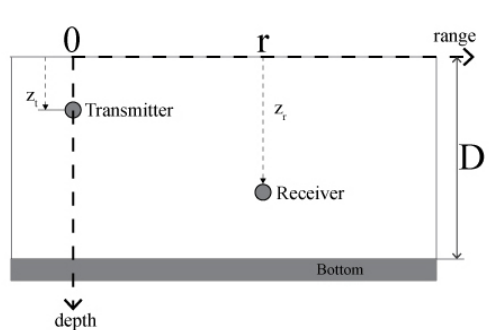
Figure 1. The considered underwater isovelocity setup. Water depth is D , transmitter depth is z t , the receiver is positioned at depth z r , and the transmitter–receiver range is r